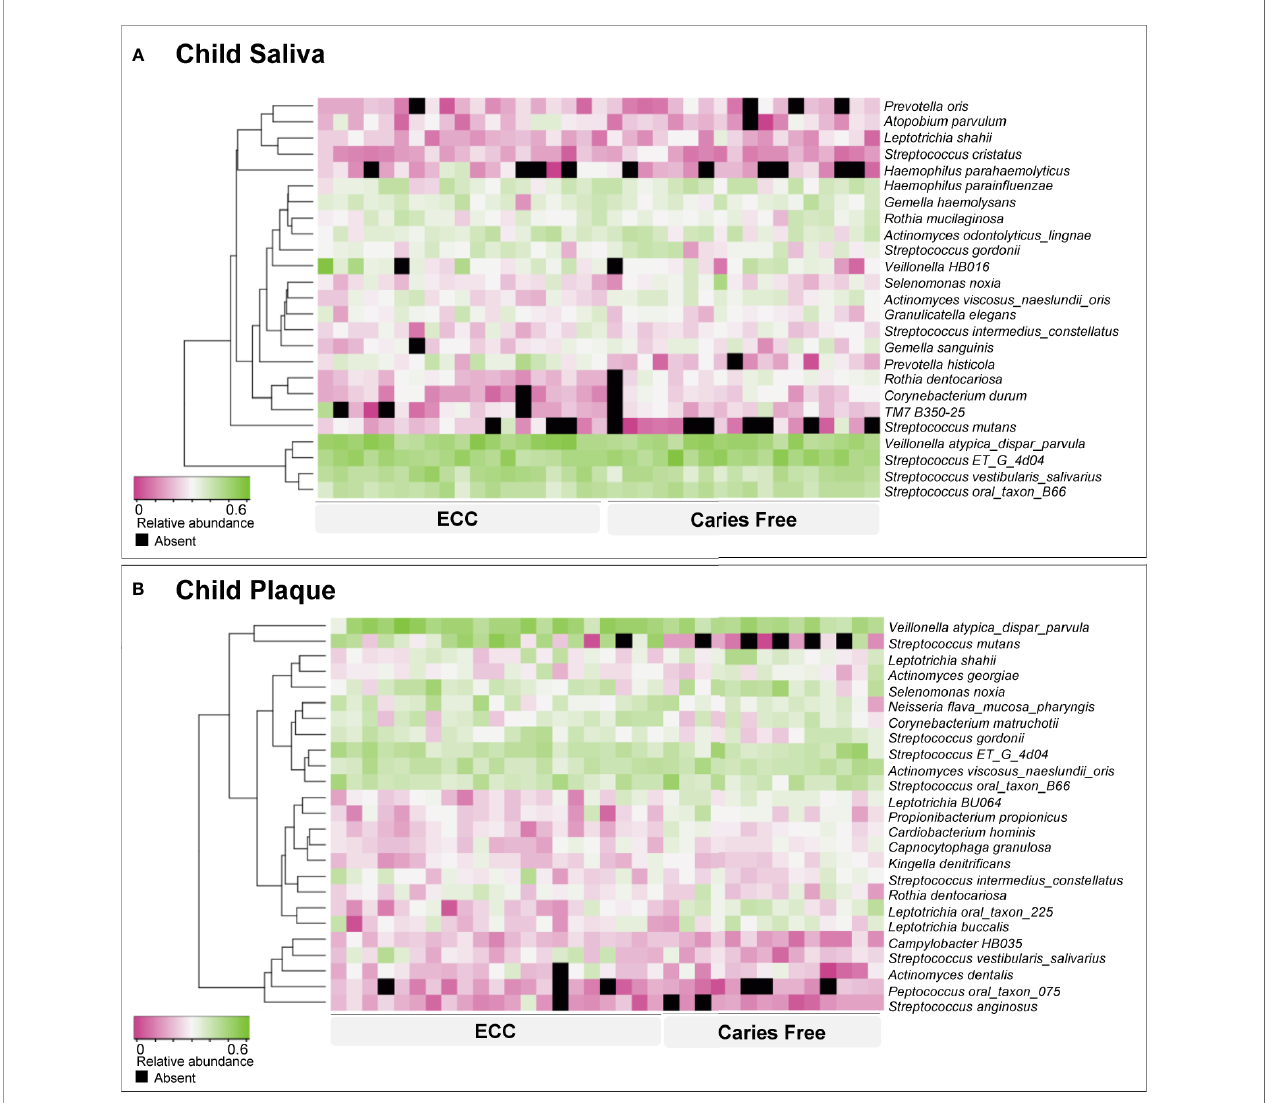
FIGURE 1 | Early childhood caries-associated and caries-free – associated oral microbiome in children. Based on relative abundance, the salivary (A) and plaque (B) microorganisms were clustered into ECC-associated and caries-free – associated groups, as shown by the dendrogram on the left. Relative abundance is indicated by a gradient of shades from pink to green. Black spots indicate no detection of the